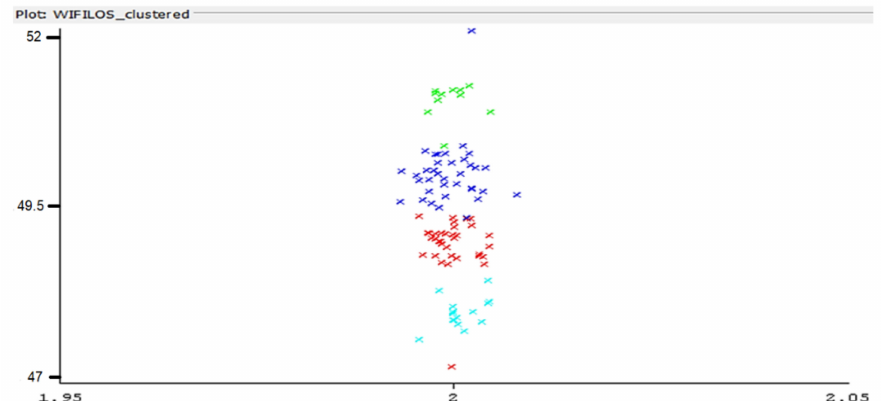
Figure 13. Weka Linear Regression classifier errors plotted for experimental results sequence 4 of tests (Vertical Axis—predicted values, Horizontal Axis—real distances). Colors represent belonging of errors to different clusters.